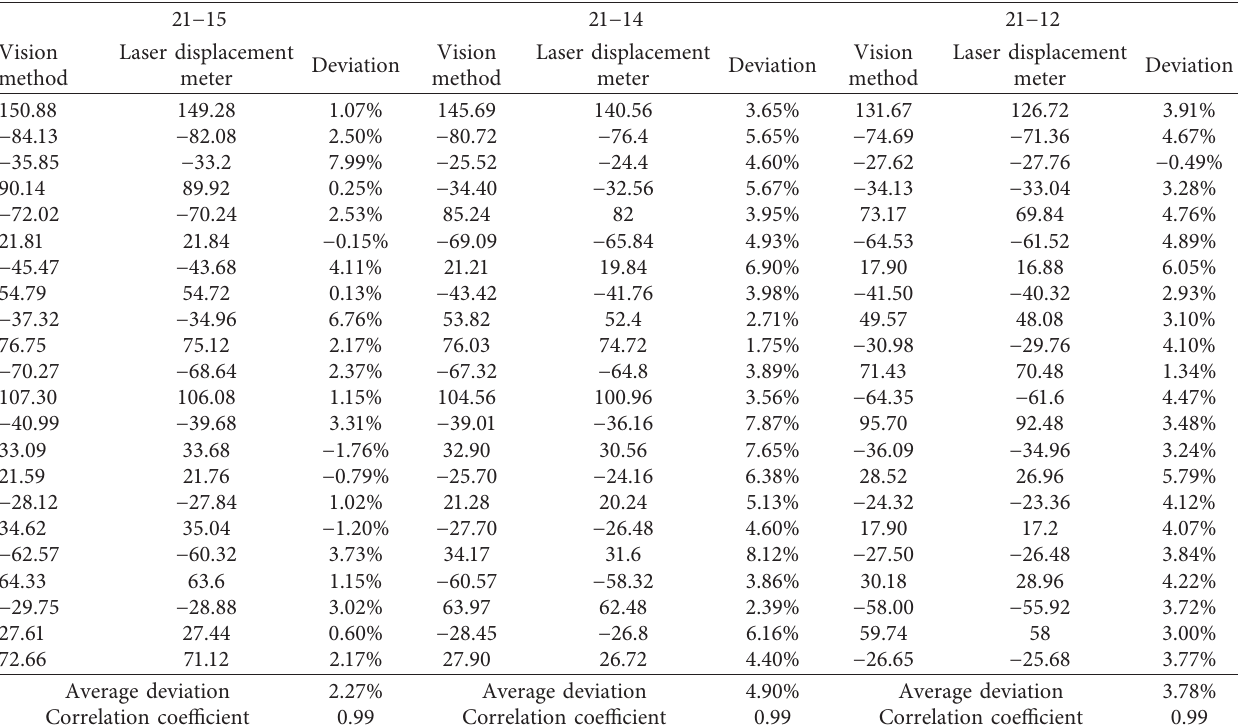
Table 3: Horizontal maximum displacement error and correlation coefficient of each floor under the working condition